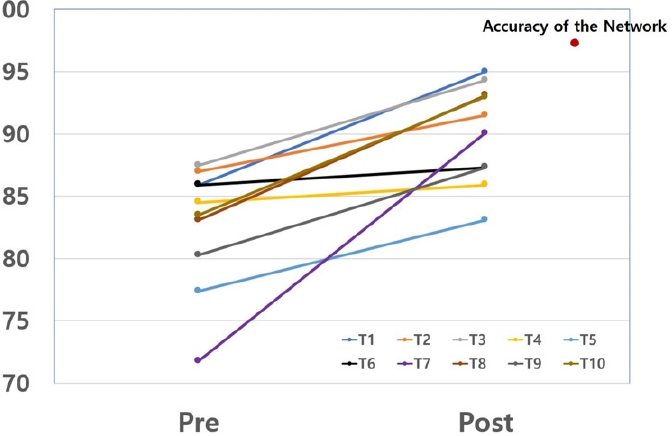
Figure 6. The diagnostic accuracy for middle ear diseases was increased in resident physicians after consultation with the machine learning model.